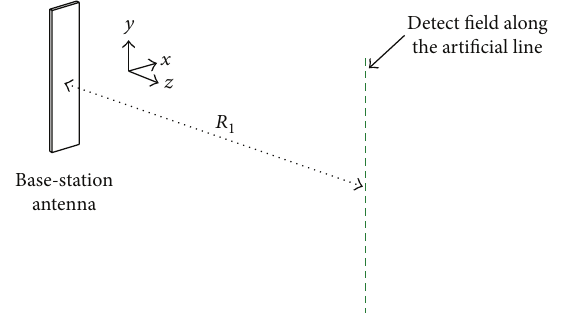
Figure 2: Simulation model of base-station